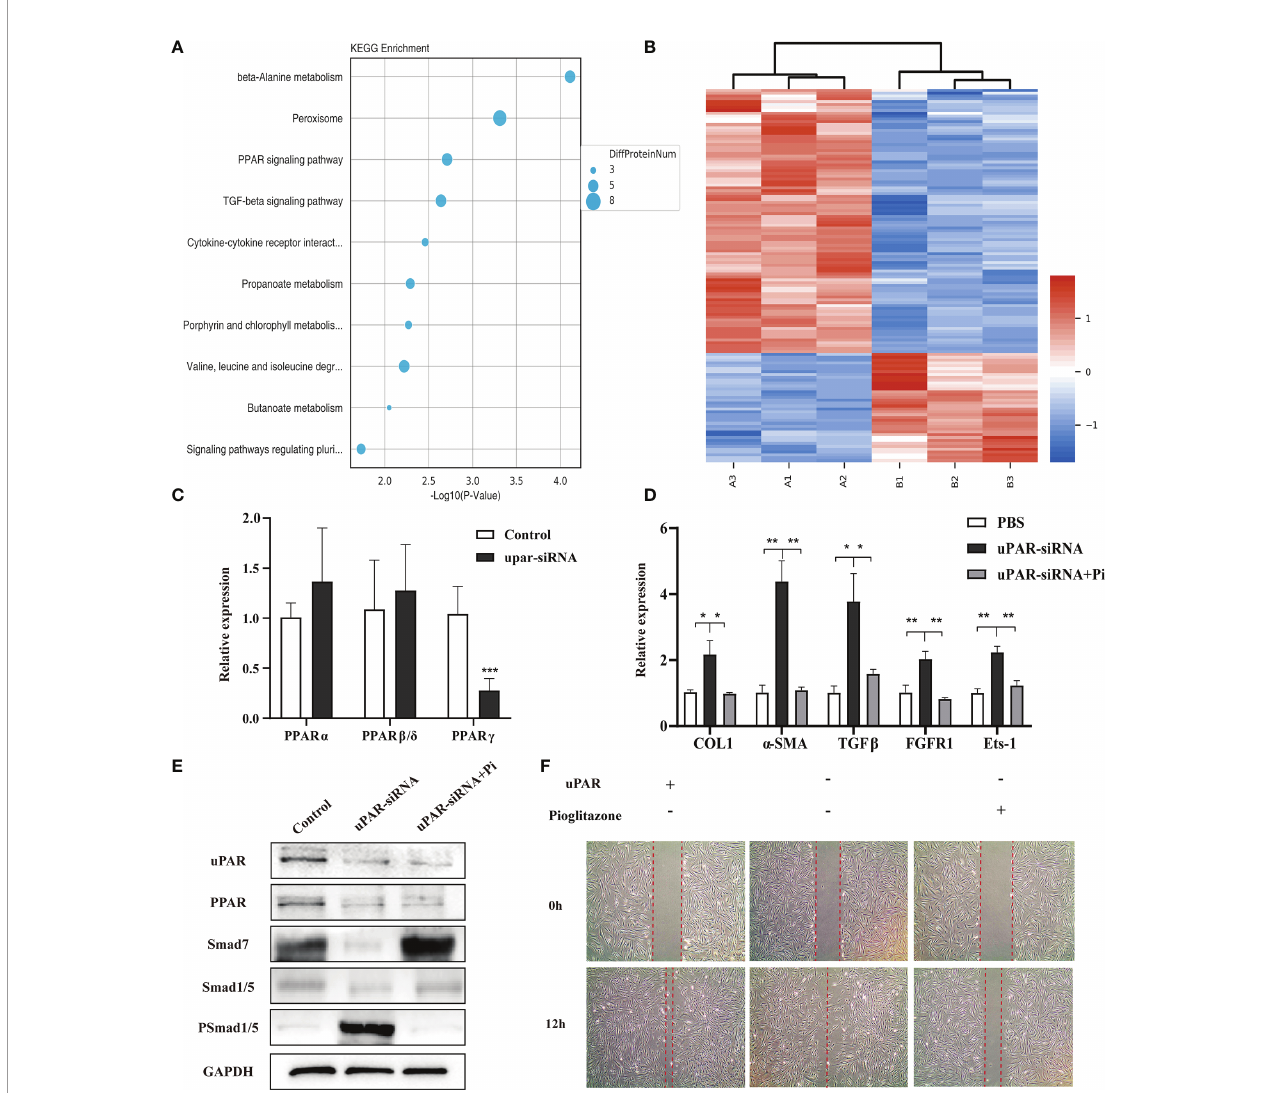
FIGURE 6 | uPA-uPAR regulates the PPAR signalling pathway. (A) KEGG pathway enrichment analysis. (B) Cluster analysis of the different protein expression between fi broblasts of uPAR knockdown and control groups. (C) mRNA levels of PPAR a , PPAR b , and PPAR g in uPAR-siRNA treated fi broblasts and control groups. (D) PPAR g agonist reversed the effects of silencing uPAR on the expression of fi brotic factors in fi broblasts. qRT-PCR assay was used to analyze the mRNA levels of COL1, a -SMA, TGF b , FGFR1 and Ets-1. (E) Analysis of signaling pathway related proteins by western blot. (F) PPAR g agonist reversed the effects of silencing uPAR on cell migration. *P < 0.05, **P < 0.01 and ***P < 0.001 when compared between the denoted